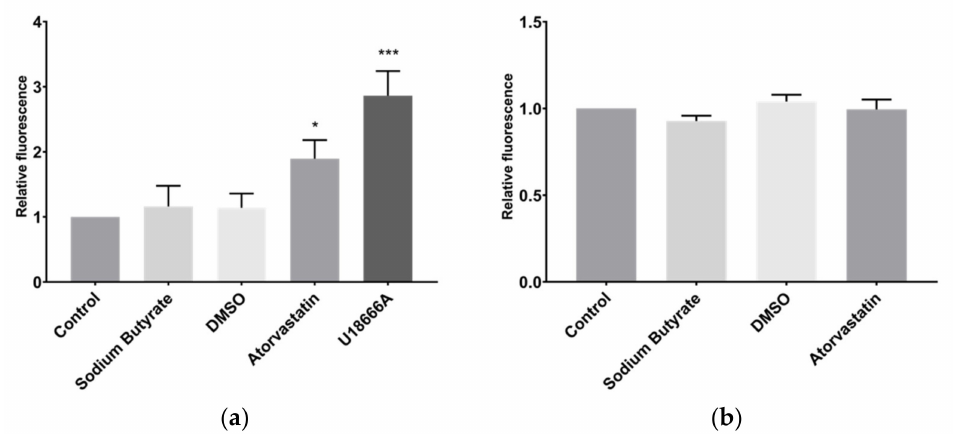
Figure 4. HepG2 cholesterol uptake is increased by atorvastatin and U18666A, but not by butyrate, and no treatment influenced cholesterol export. ( a ) Uptake of fluorescently tagged NBD-cholesterol by HepG2 cells; ( b ) Export of fluorescently tagged NBD-cholesterol from HepG2 cells. Cells were treated with 10 µ M atorvastatin or 5 mM sodium butyrate for 24 h. Control cells were treated with media only for butyrate and media containing DMSO for atorvastatin. Results represent the mean from at least three independent experiments and error bars represent SEMs. * p < 0.05, *** p < 0.001.